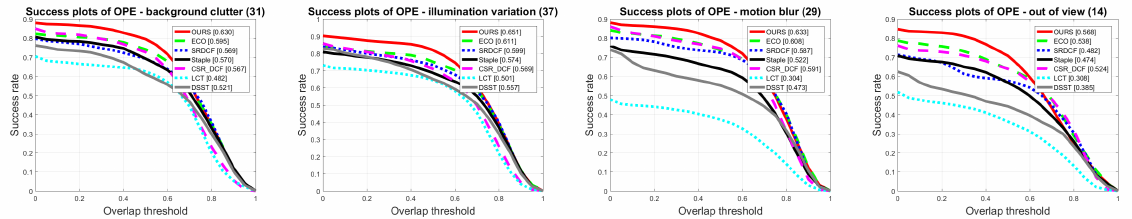
Figure 10. Success plots about Background Clutter Illumination Variation, Motion Blur and Out of View attributes on